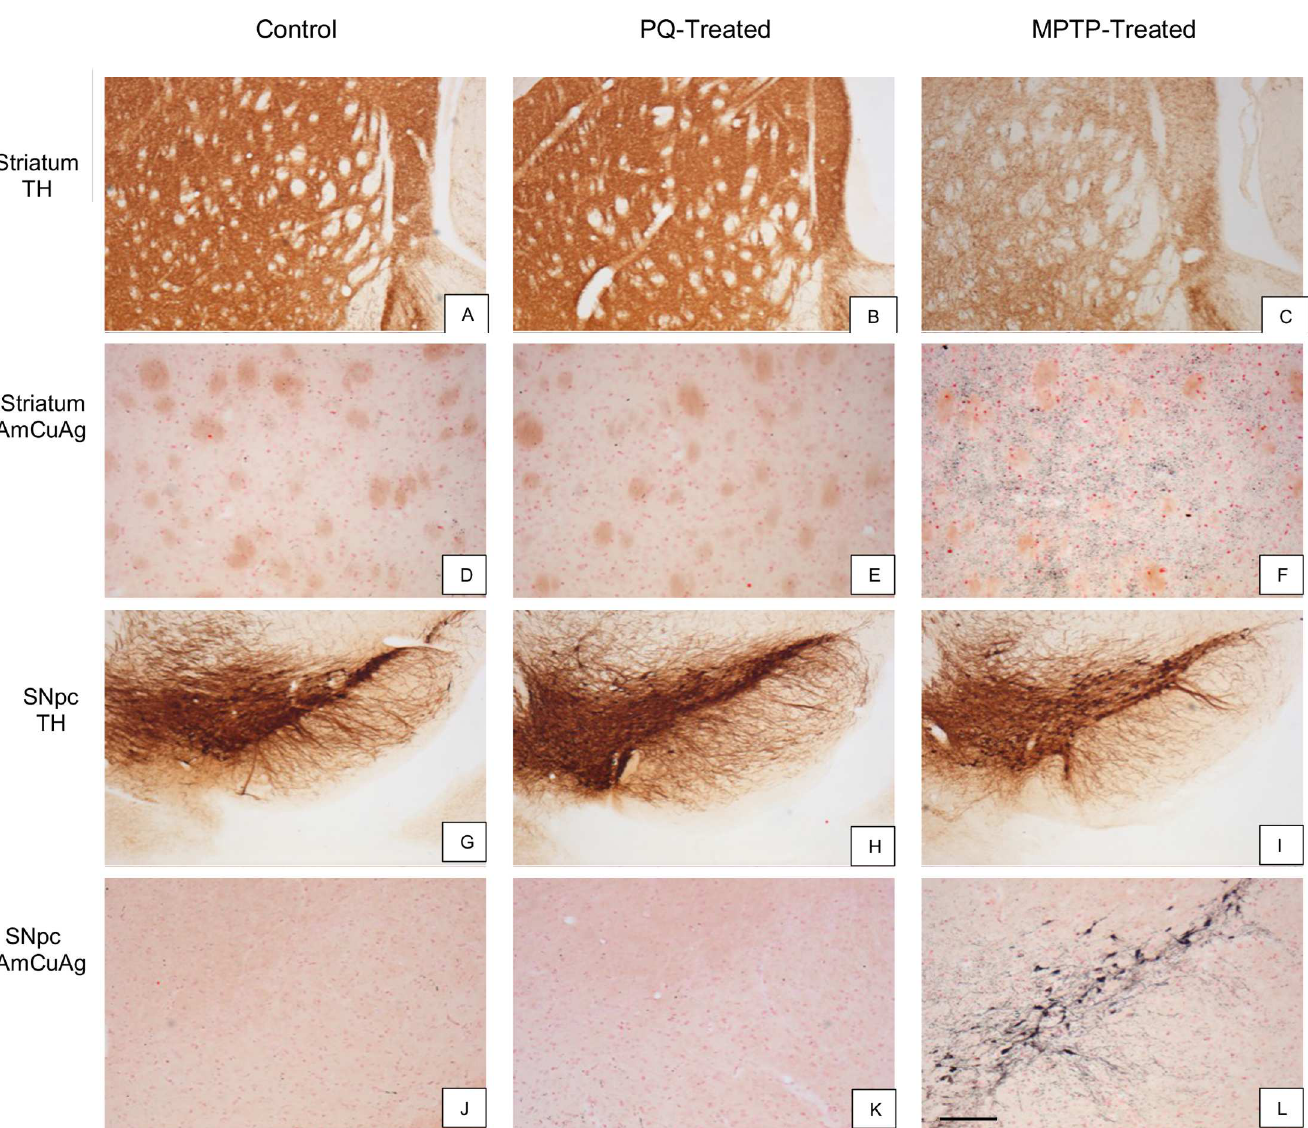
Fig 5. Pathological assessment of SNpc and striatum in PQ- or MPTP-treated mice. Microscopic appearance of the SNpc (G-L) and striatum (A-F) in control (column 1), PQ- (column 2) or MPTP-treated (column 3) mice, 48 hours after dosing. Tyrosine hydroxylase(TH) immunostaining was decreased in the striatum (C) and SNpc (I) of the MPTP-treated animal but was unchangedin the PQ-treated mouse (B, H) compared to the control (A, G). Amino cupric silver (AmCuAg) staining was used to reveal degeneratingneuronsin the SNpc (J-L) and degenerating fibers in the striatum (D-F). There were no differences in AmCuAg staining in either the SNpc or striatum after PQ treatment comparedto the control (D,J). AmCuAg staining was increasedin the SNpc and striatum of the MPTP-treated mouse (F,L). The scale bar shown in Panel L represents 400 μ m in panelsA-C, G-I and 40 μ m in panels D-F and